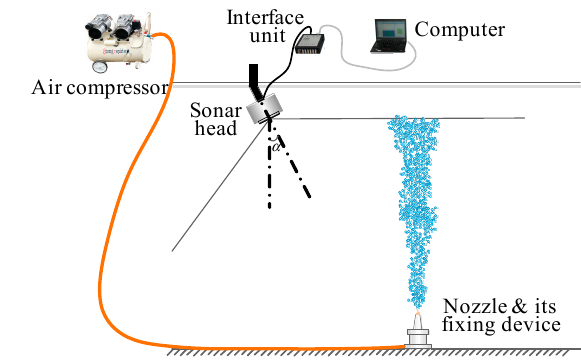
Figure 4. Schematic diagram of the pool experiment for simulation of leaking gases.